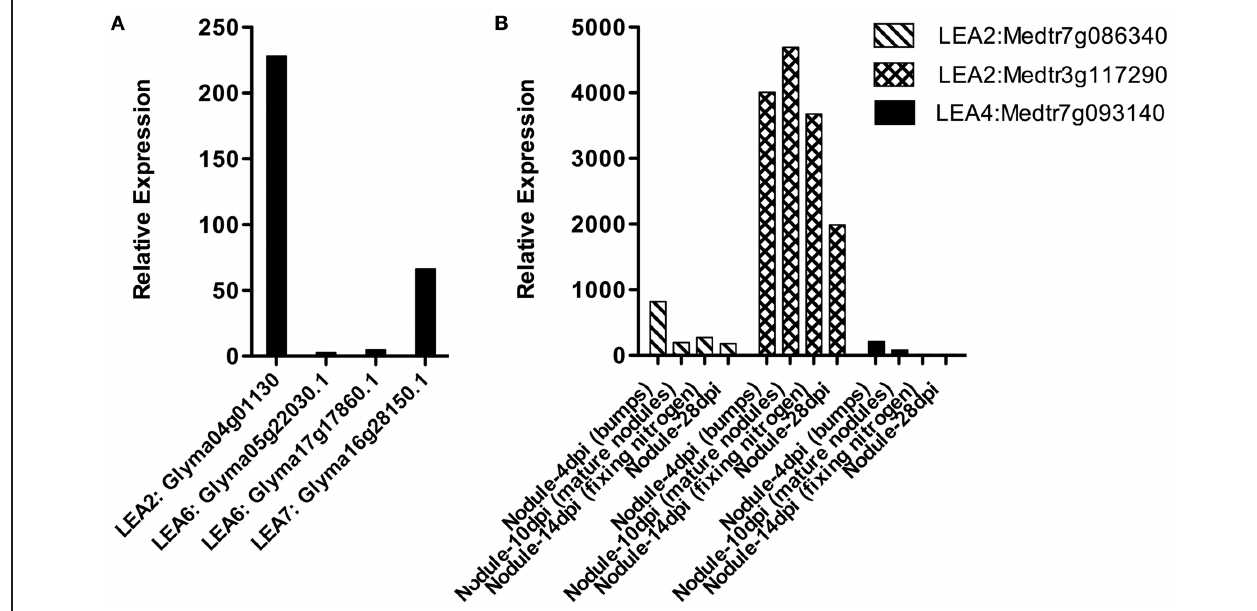
FIGURE 3 | LEA gene expression patterns obtained using RNA isolated from Glycine max (A) or Medicago truncatula (B) nodules. (Benedito et al., 2008; Libault et al., 2010b; Severin et al., 2010; Joshi et al., 2012). dpi: days post-infection.